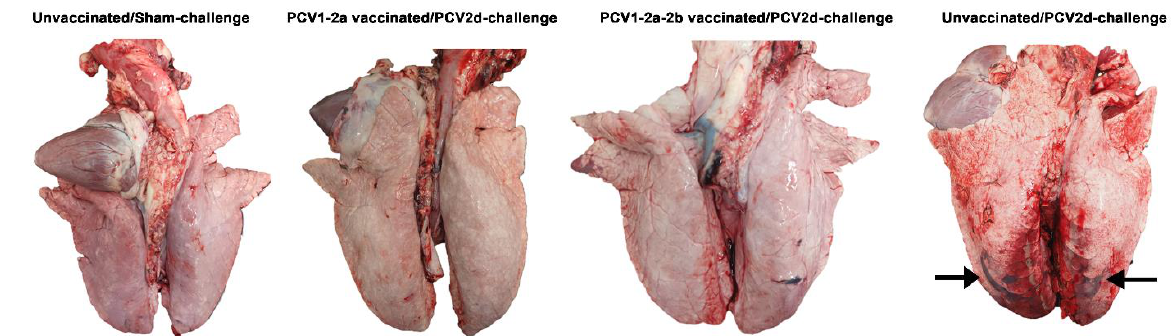
Figure 1. Macroscopically, predominant lesions of hemorrhagic pneumonia were observed in the unvaccinated/PCV2d-challenge pigs (arrows), while pigs in the PCV1-2a/PCV2d-challenge and PCV1-2a-2b/PCV2d-challenge groups displayed symptoms of mild hemorrhagic pneumonia.